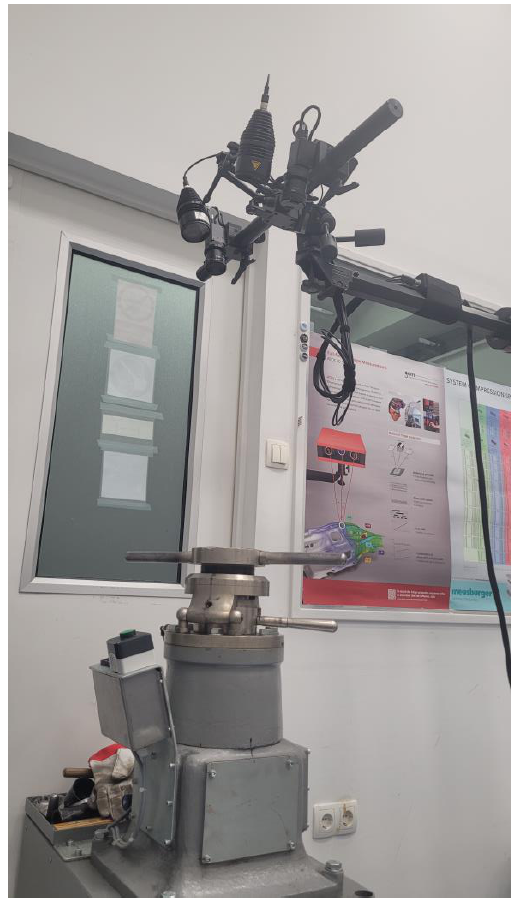
Figure 10. Erichsen testing equipment with GOM ARAMIS 5M DIC system (own photo).